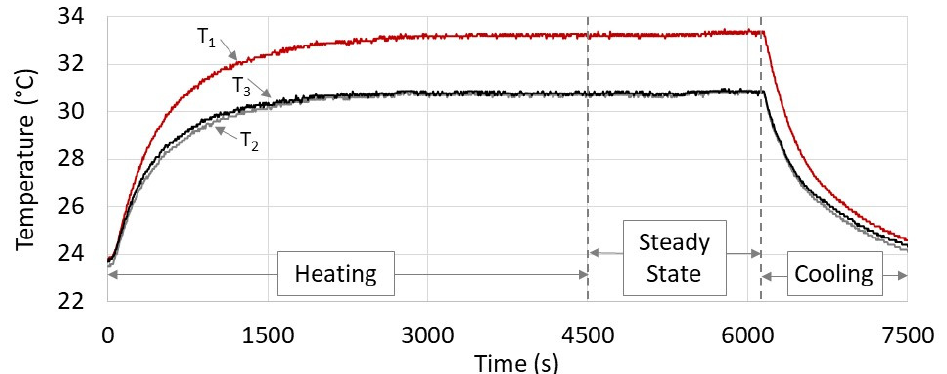
Figure 4. Thermocouple measurements recorded while testing the red LSC. The temperature profiles measured at positions one, two and three (positions shown in Figure 3) are denoted as T 1 , T 2 , and T 3 , respectively. While the uncertainty of the temperature measurements is greater than ± 2 °C, it is assumed that steady state is reached when the temperature and mean temperature over a duration of 25 min differ by less than ± 0.2 °C.